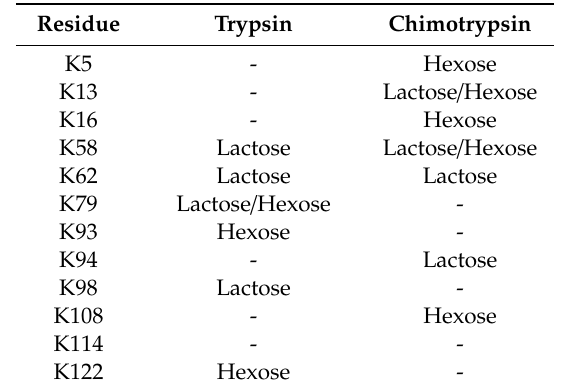
Table 3. A full list of identified peptides is given in Supplementary Materials. Table 2. Glycation sites identified in α -lactalbumin after tryptic and chymotryptic digestion of whey samples from UHT